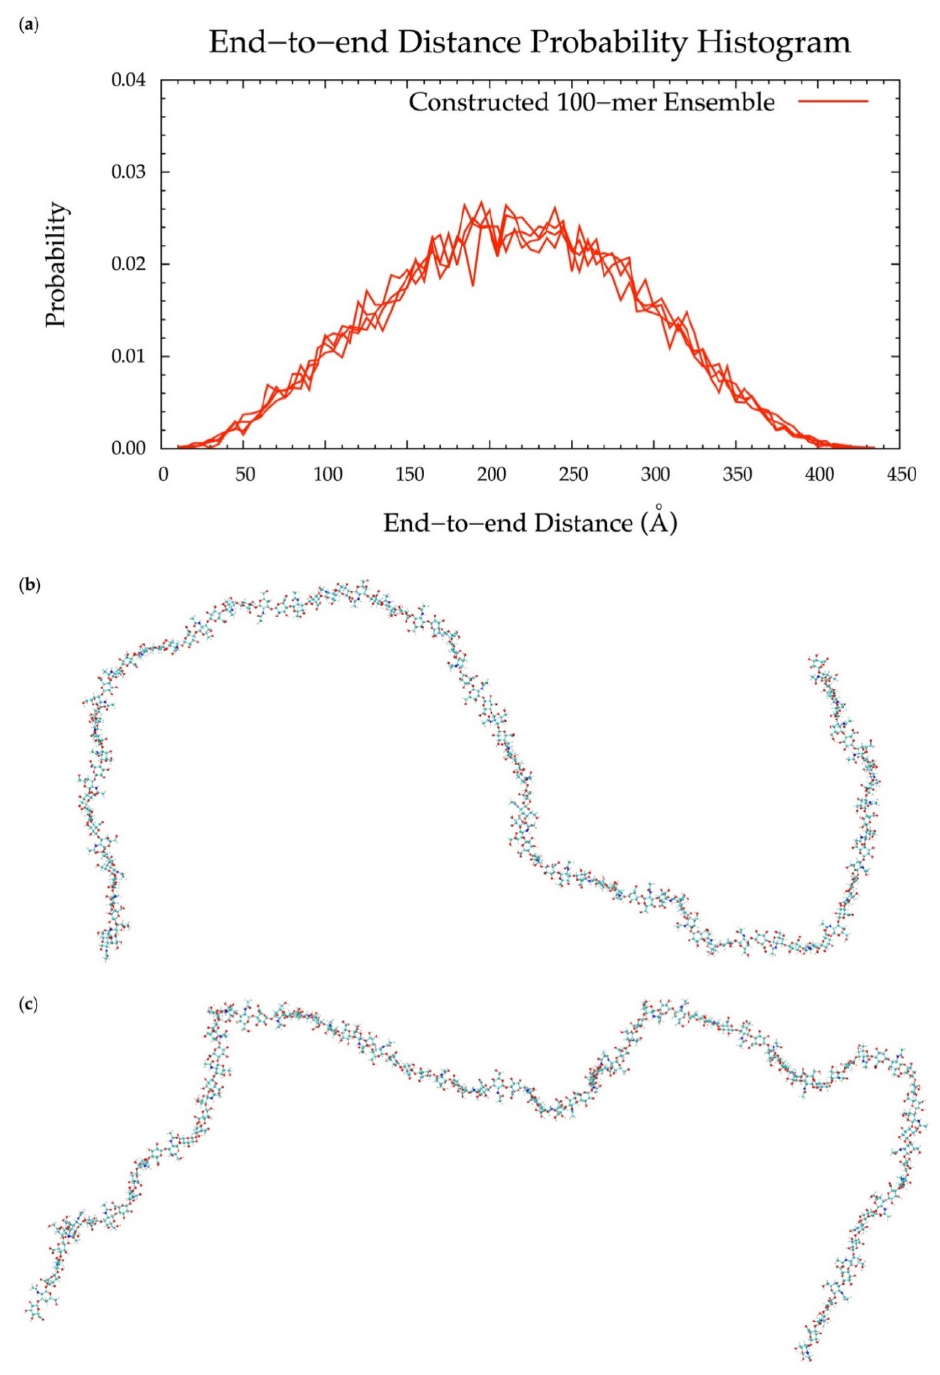
Figure 11. ( a ) End-to-end distance probability distribution of constructed 100-mer ensemble; includes four sets of 10,000 conformations; probabilities were calculated for end-to-end distances sorted into 5 Å bins. ( b , c ) Snapshots of the non-sulfated chondroitin 100-mer having the most-probable end-to-end distance (225 Å in both snapshots) from constructed ensembles.